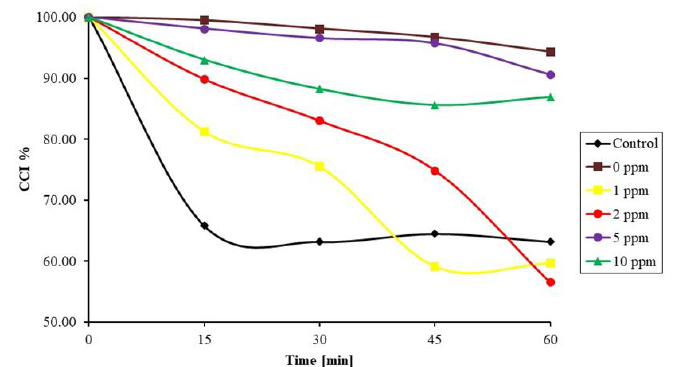
Figure 4. Effect of different dosages of amino tris(methyl phosphonic acid (ATMP) on ultrasonication with the control sample. At a lower dosage (1 mg/L), the treatment is not sufficient; 5 or 10 mg/L of ATMP is required to obtain comparable ultrasonication performance.